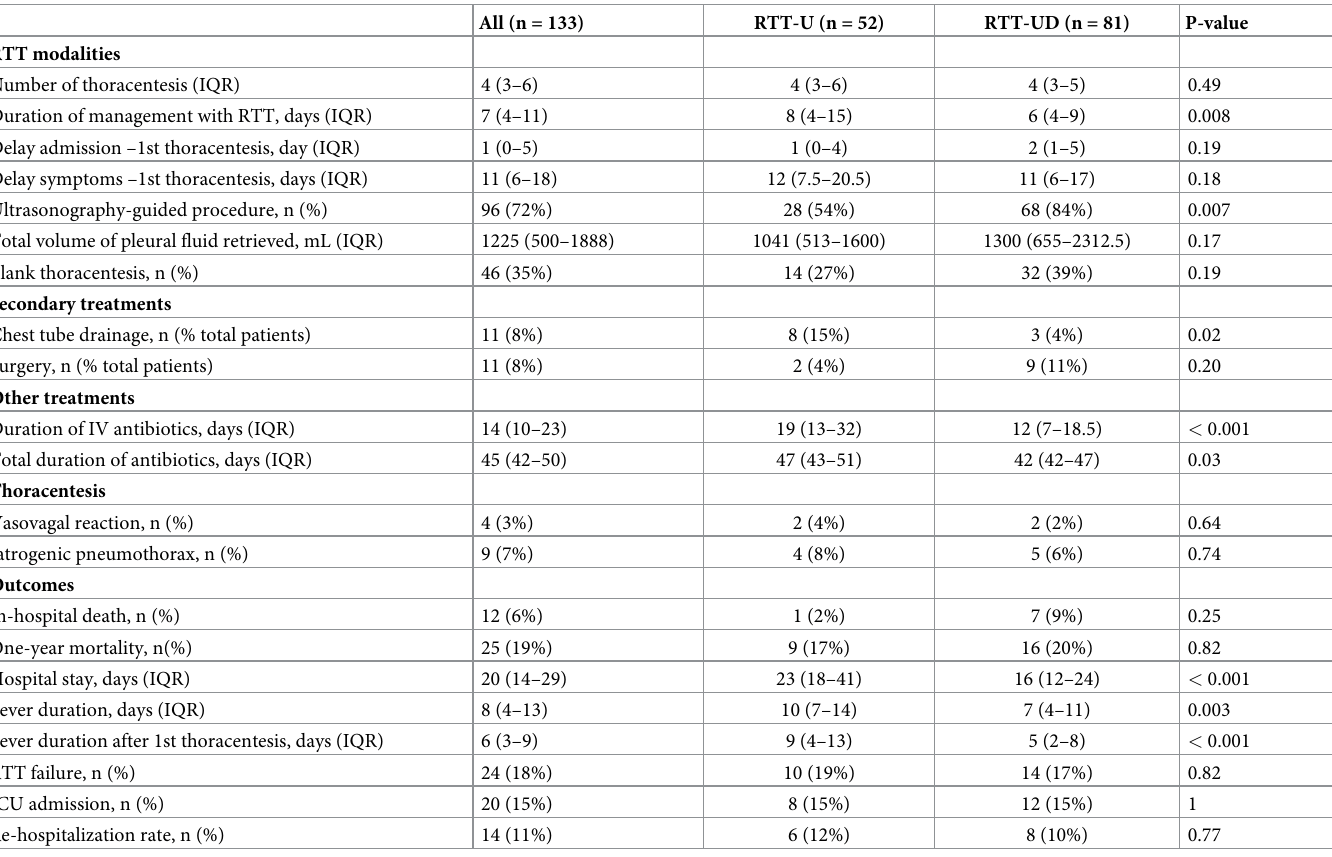
Table 2. Management and outcomes of the study